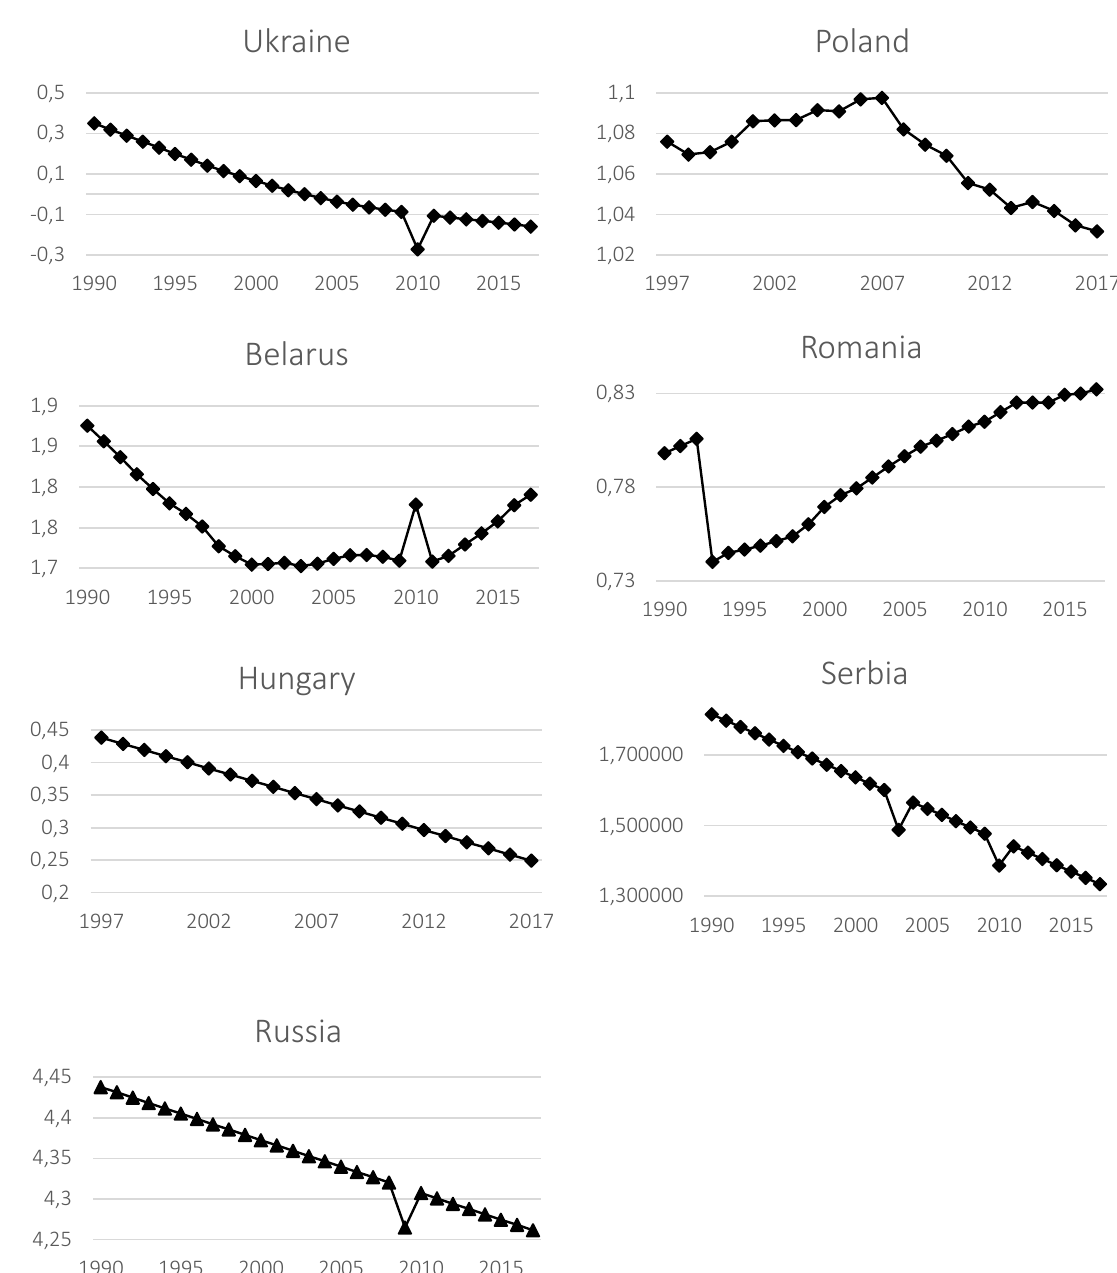
Figure A1. Underlying CO